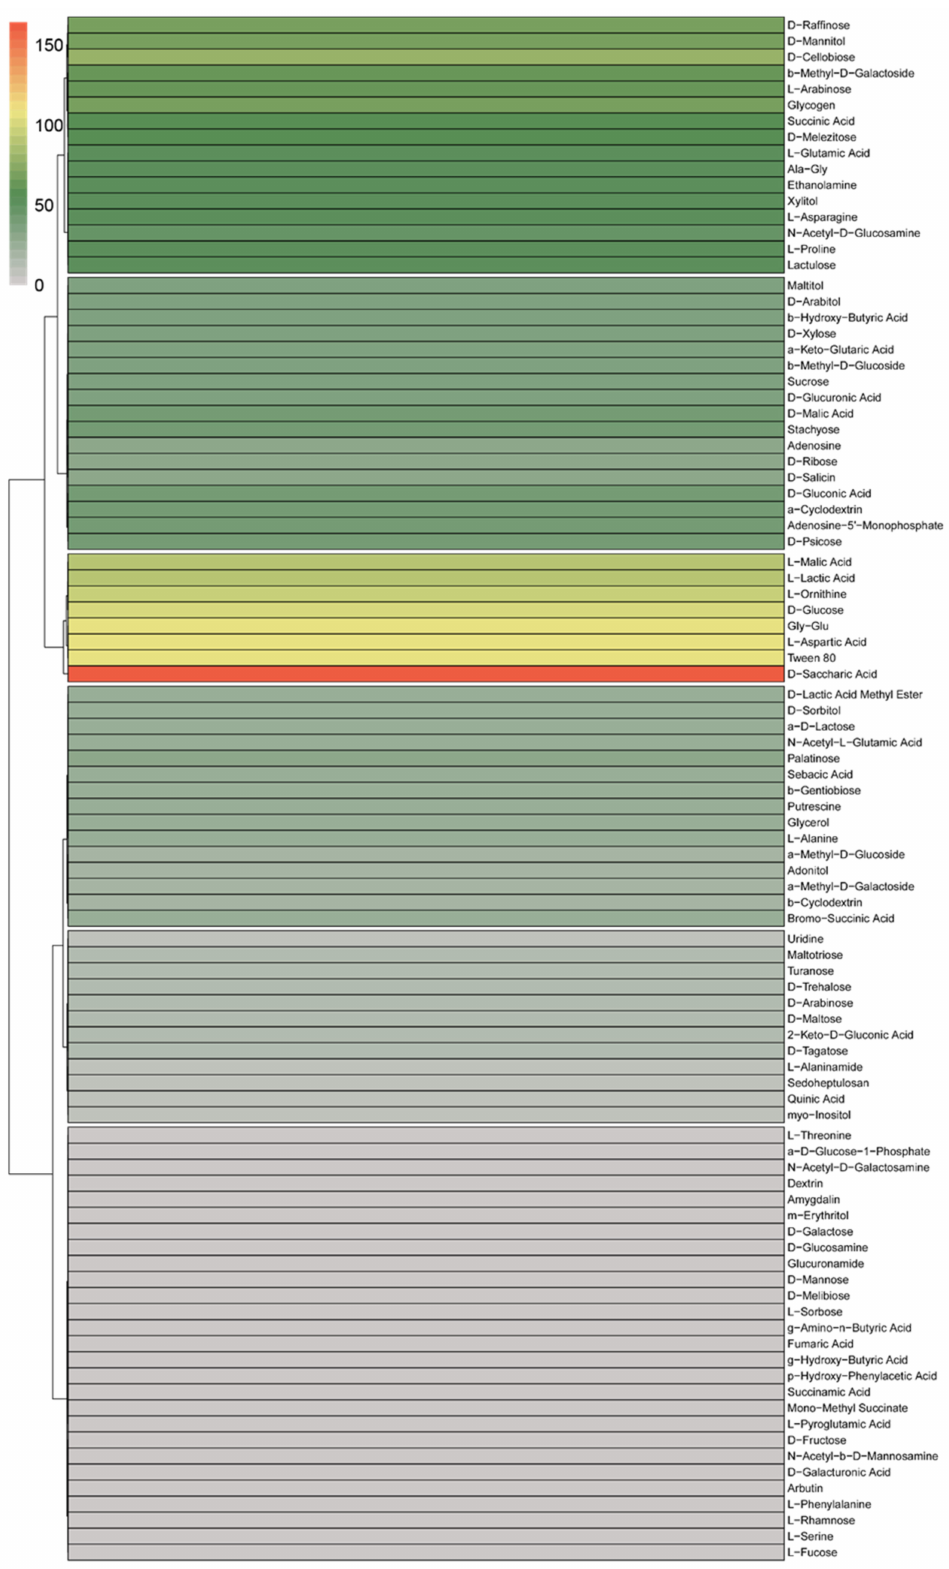
Figure 4. The heatmap presenting utilization of all substrates by analyzed endophytic strain (168 h of